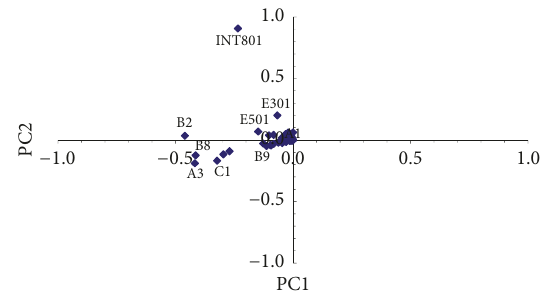
Figure 6: PCA of the total samples and possible PAH/H-C point sources.